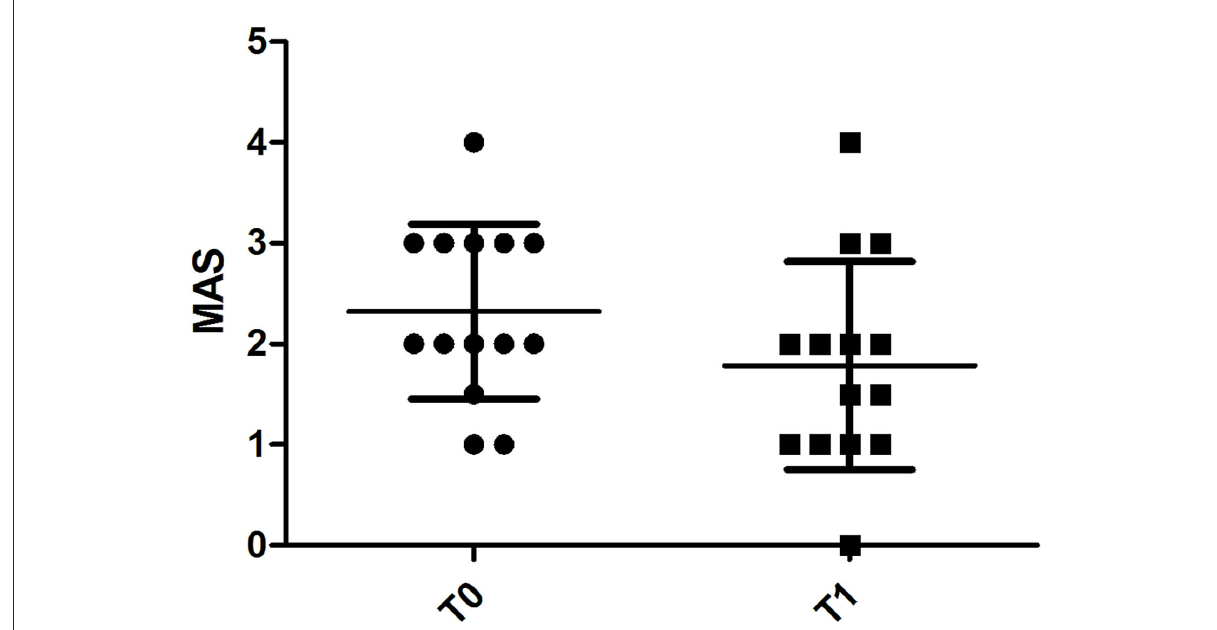
FIGURE3 Chart illustrating the significant difference in MAS score assessments of spastic muscles before (T0) and 4 weeks after (T1) BoNT-A injection.